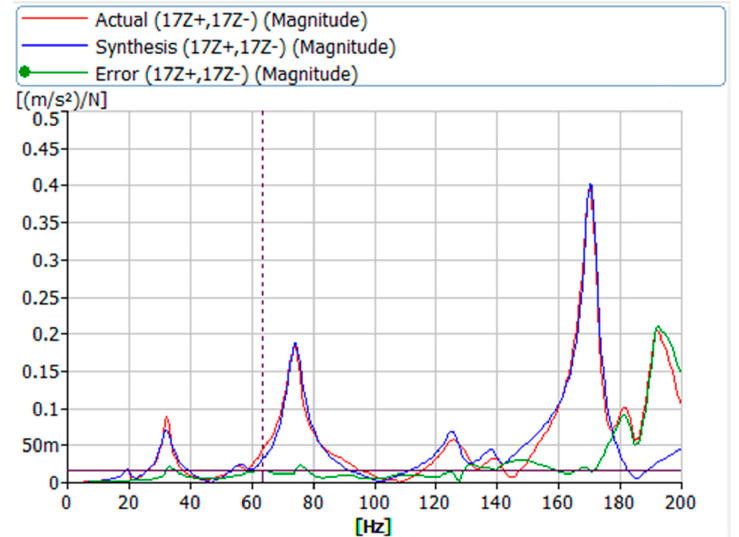
Figure 5. Synthesized FRF, measured FRF, and relative errors between the synthesized FRF and the measured FRF.